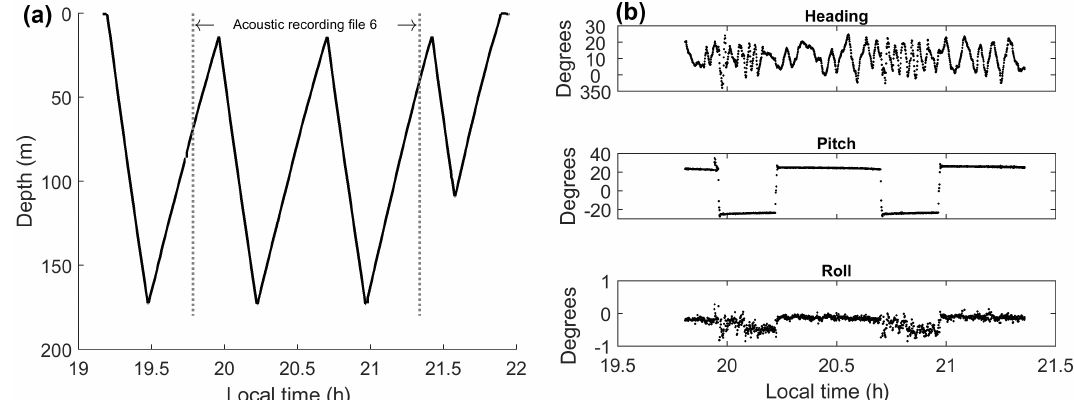
Figure 12. Panel (a) shows the glider’s dive profile during the recording of the acoustic data used in this work. Navigation parameters of the glider (heading, pitch, and roll) are shown in (b) . Note the highly oscillatory pattern of the glider